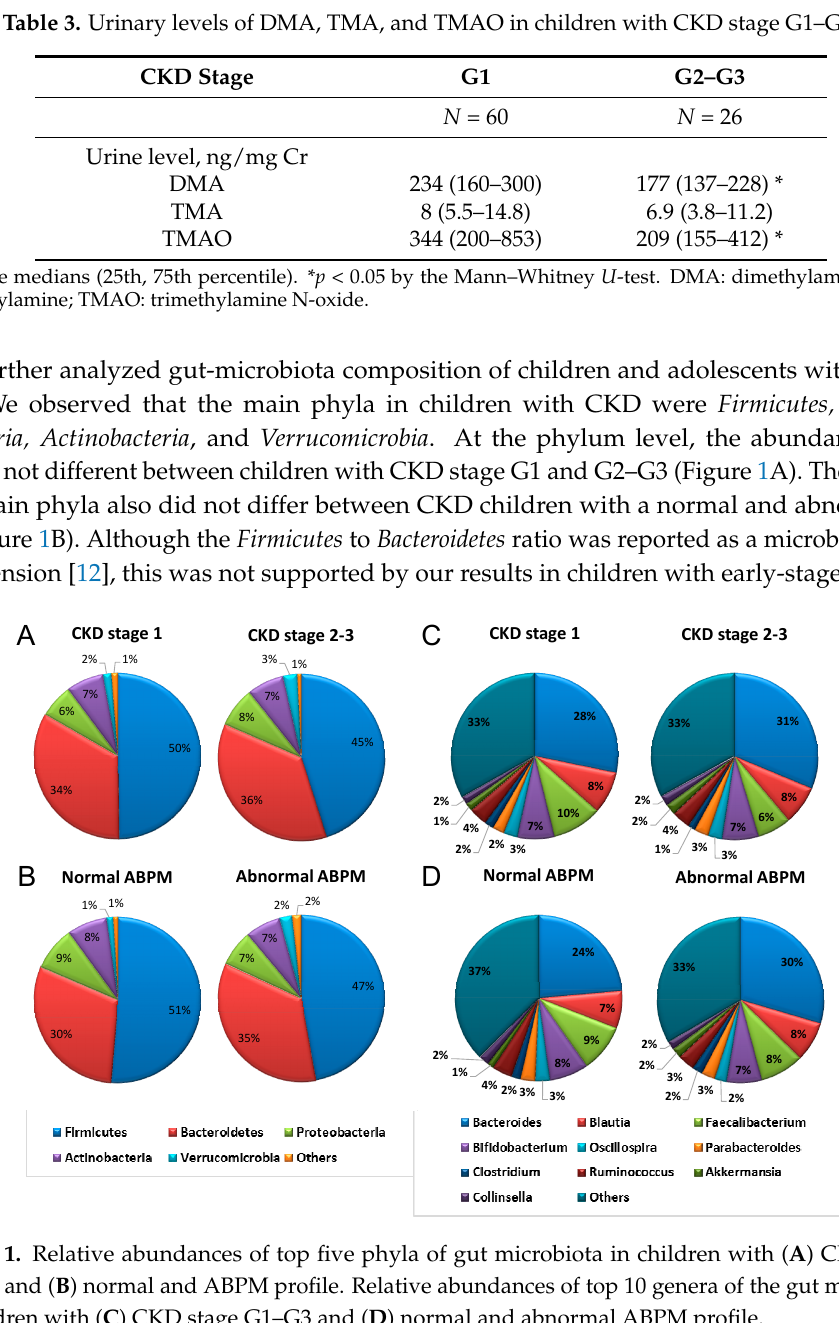
Table 3. Urinary levels of DMA, TMA, and TMAO in children with CKD stage G1–G3.